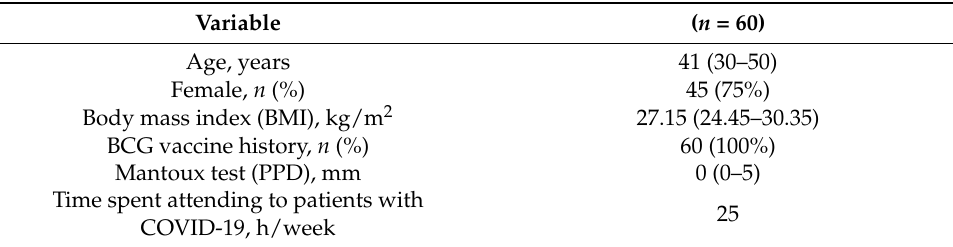
Table 1. Demographic description of